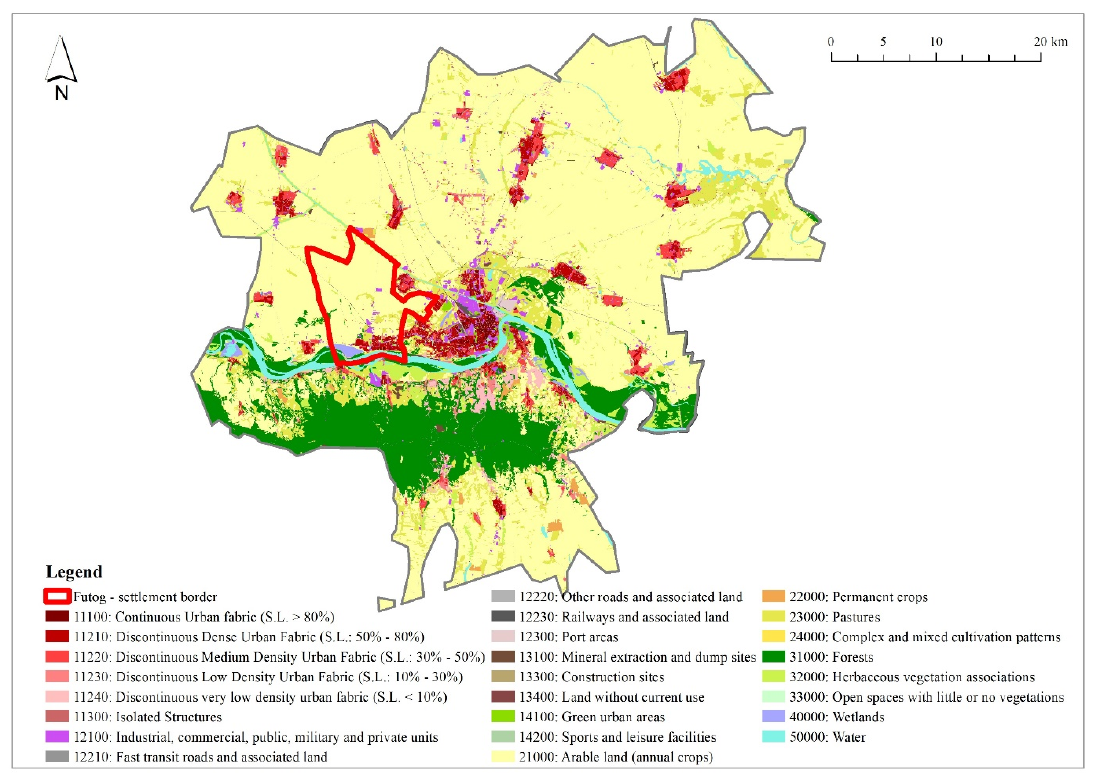
Figure 3. Land cover for Novi Sad FUA (2018).